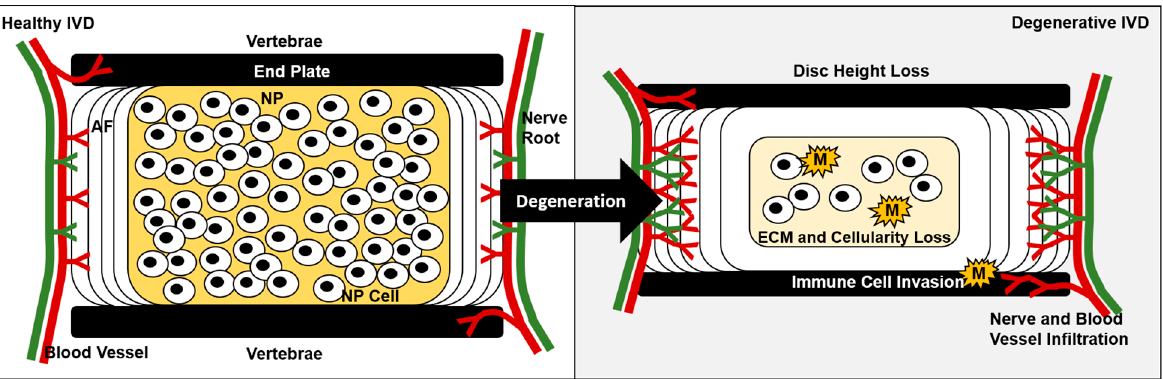
Figure 1. Changes associated with intervertebral disc degeneration. Disc height loss, ECM degrada- tion, nerve and blood vessel infiltration, inflammatory cell invasion, and loss of cellularity accompany degenerative disc